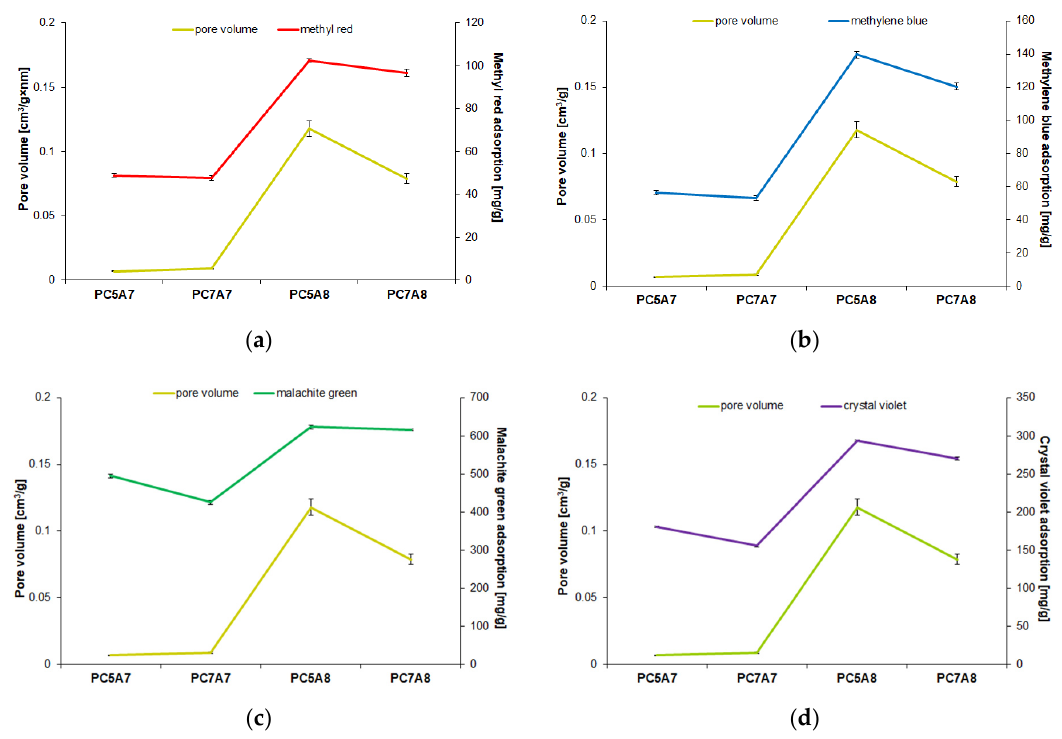
Figure 10. Dependence of the carbon adsorbents adsorption capacity on their total pore volume for adsorption of: ( a ) methyl red, ( b ) methylene blue, ( c ) malachite green, ( d ) crystal violet.